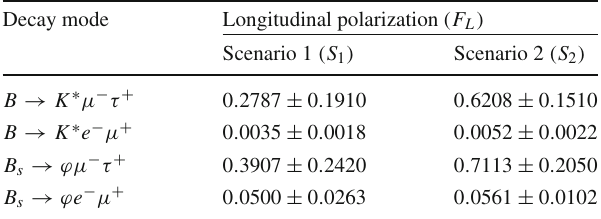
Table5 PredictedvaluesoflongitudinalpolarizationfractionsforLFV B → K ∗ and B s → ϕ decays in 1 st and 2 nd scenarios Decay